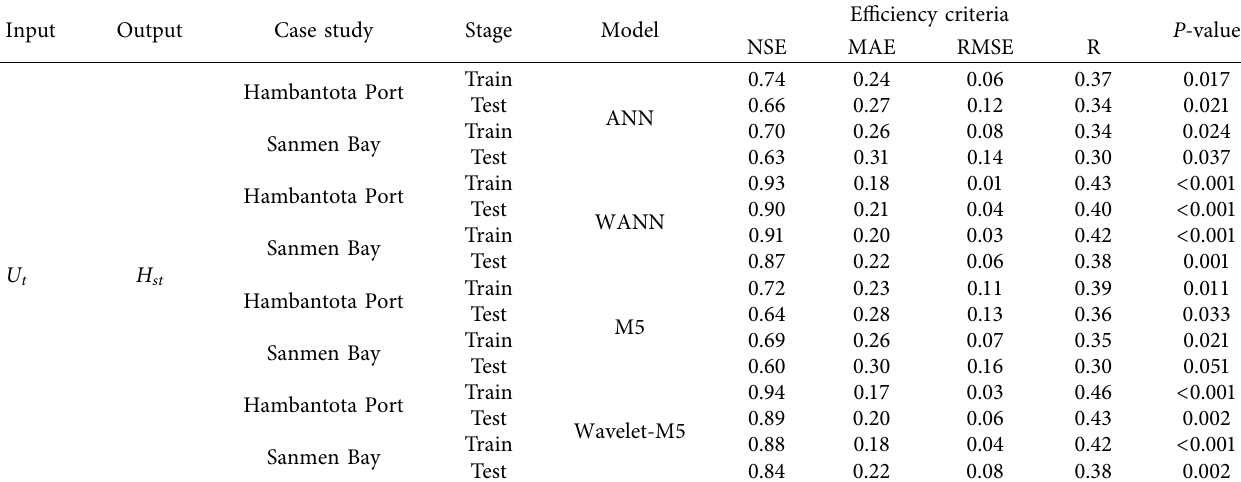
Figure 4: Times series of test and train normalized signifcant wave height and the corresponding scatter diagram by the classic ANN model (a–c) in the Hambantota Port (2020) and (d–f) in the Sanmen Bay (2017). Table 1: Results of diferent modeling for the Hambantota Port at daily